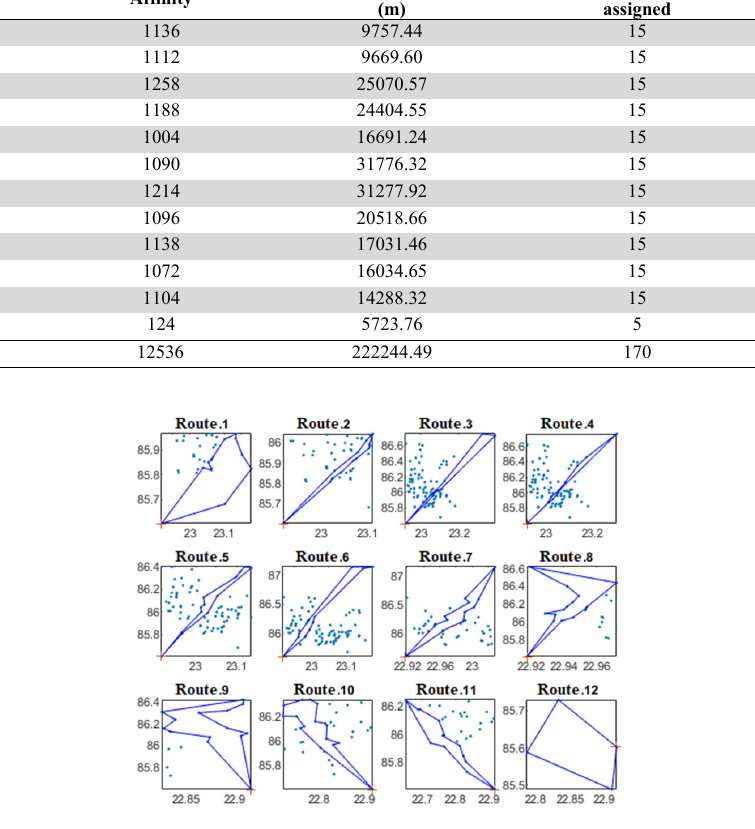
Fig. 9. Routes per vehicle with the multisweep